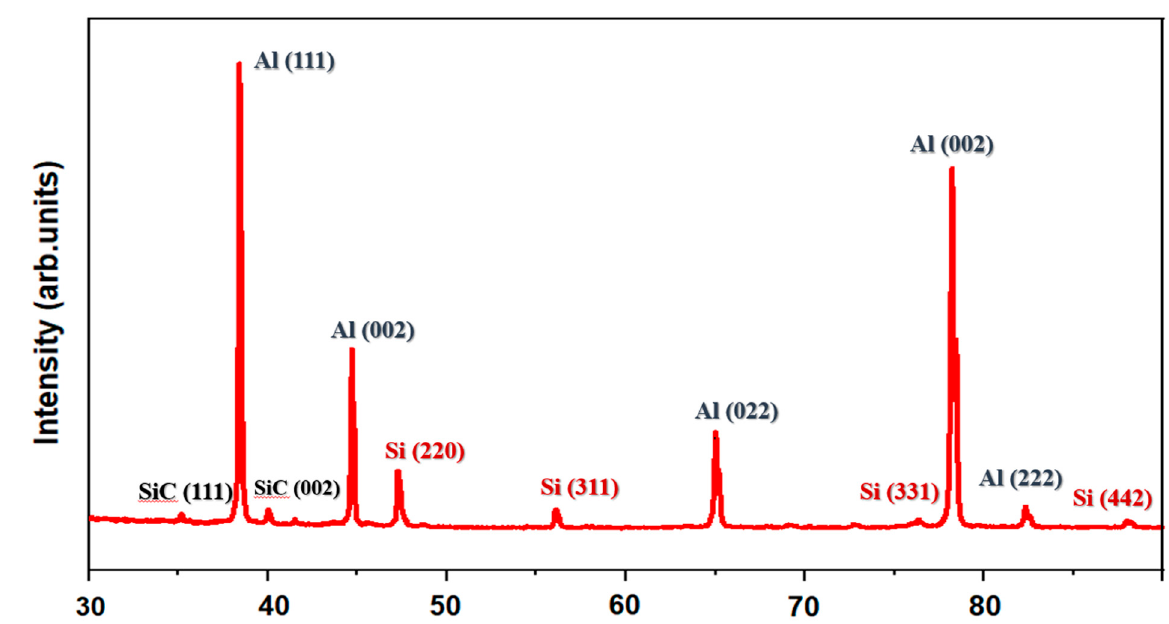
Figure 6. XRD spectrum of fabricated MMC.